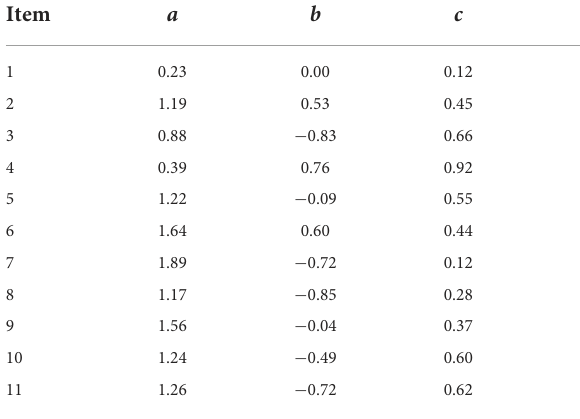
TABLE 8 Item parameter estimates under RC-3PNO model for the real data